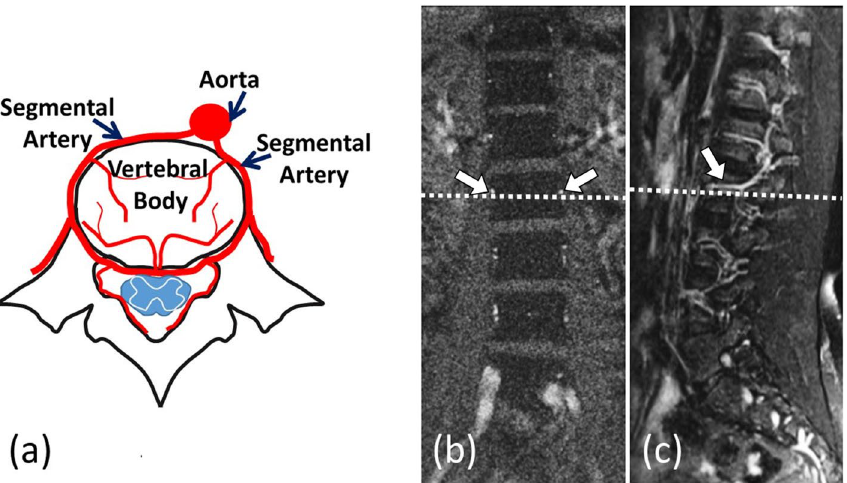
Figure 1. ( a ) The anatomic relationships between a lumbar vertebral body and its supplying arteries, including the abdominal aorta and segmental arteries. The axial plane through the L1 segmental arteries (just above the dotted lines) was selected on coronal ( b ) and sagittal ( c ) images of magnetic resonance angiography. White arrows indicate the segmental arteries.